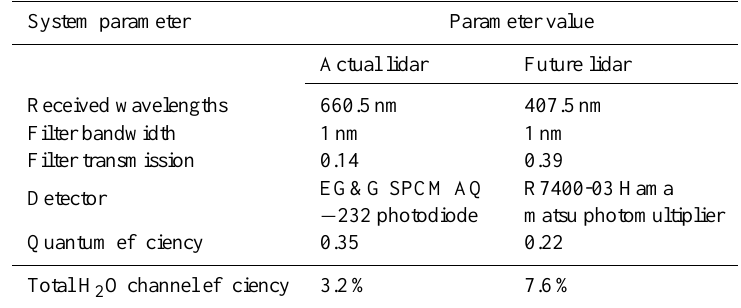
Table 2. System Parameters for H 2 O channel for the actual and future lidar system.